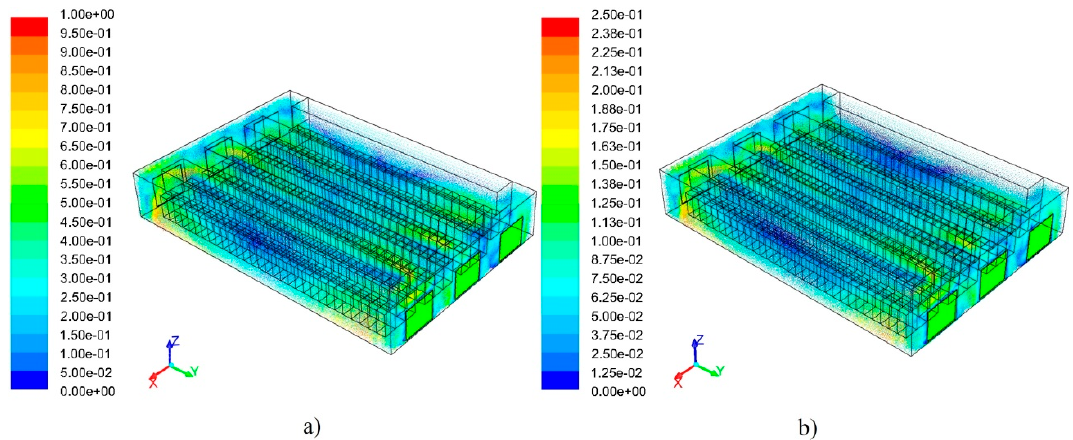
Figure 21. The representation of three-dimensional geometry of velocity vectors for: ( a ) maximum air flow velocity; and ( b ) minimum air flow velocity.